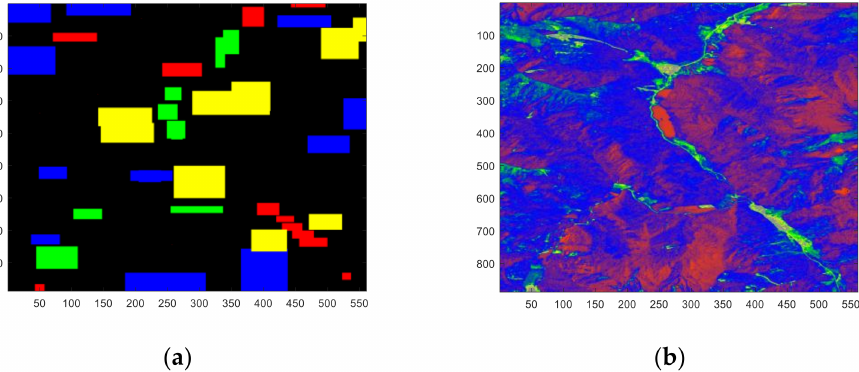
Figure 7. The classification effects of HRSIs after Jiuzhaigou M7.0 earthquake. ( a ) Four types. ( b ) Six